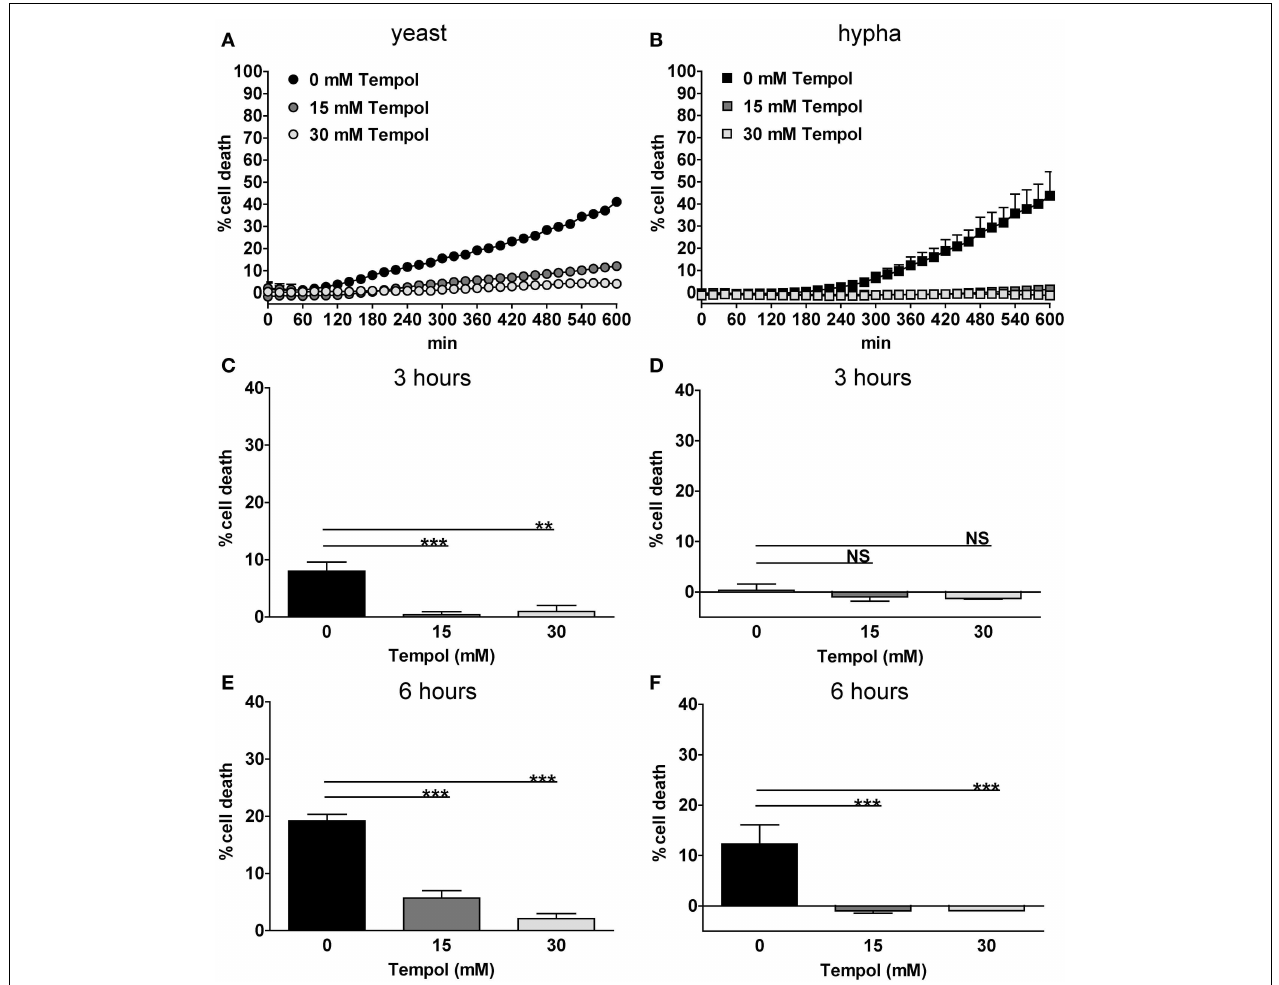
Black curves: PMNs infected with C. albicans , gray curves: PMNs infected with C. albicans in the presence of different concentrations ofTempol.To allow for better comparison with microscopic analyses, the effect ofTempol on PMN cell death after infection with C. albicans at 3h (C,D) and 6h (E,F) time points was compared in respect of the different cell morphotypes used. Significance was analyzed byTukey one-way ANOVA (NS: P > 0.05, ** P ≤ 0.01, and *** P ≤ 0.001). One representative experiment out of three independent experiments with three different donors is shown. Data are presented as means of three technical replicates ±